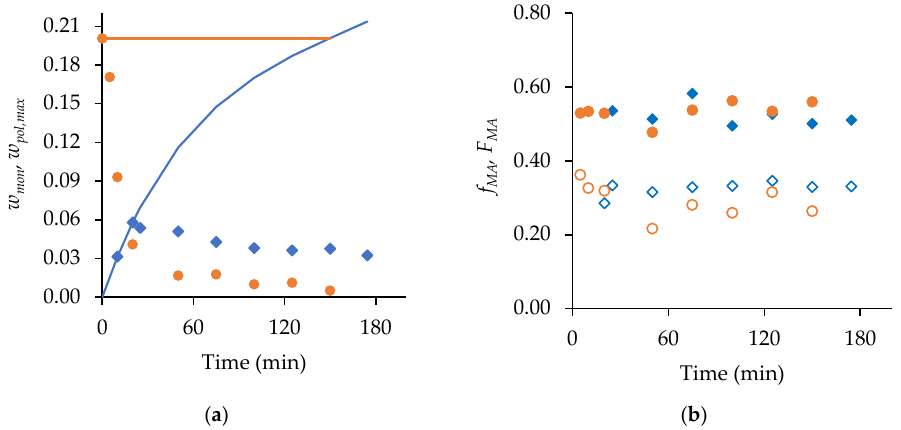
Figure 5. A comparison of semi-batch ( ) and batch ( ) MA/t-BuAAm copolymerization with 0.50 mole fraction of MA and a final monomer/polymer content of 20 wt% in 75/25 EtOH/H 2 O with 1 wt% AIBN at 60 ℃ : ( a ) w mon (symbols) and w pol,max (line) vs. time, ( b ) Mole fraction of MA in copoly- mer ( F MA , filled symbols) and unreacted comonomer mixture ( f MA , open symbols) vs. time.